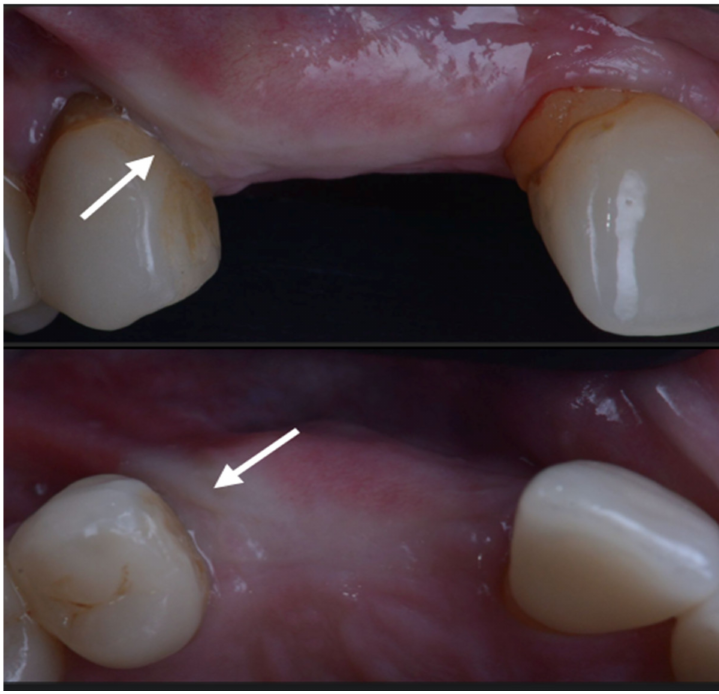
Figure 16. Healing at 6 months, the arrows point to the step created by the lamina.